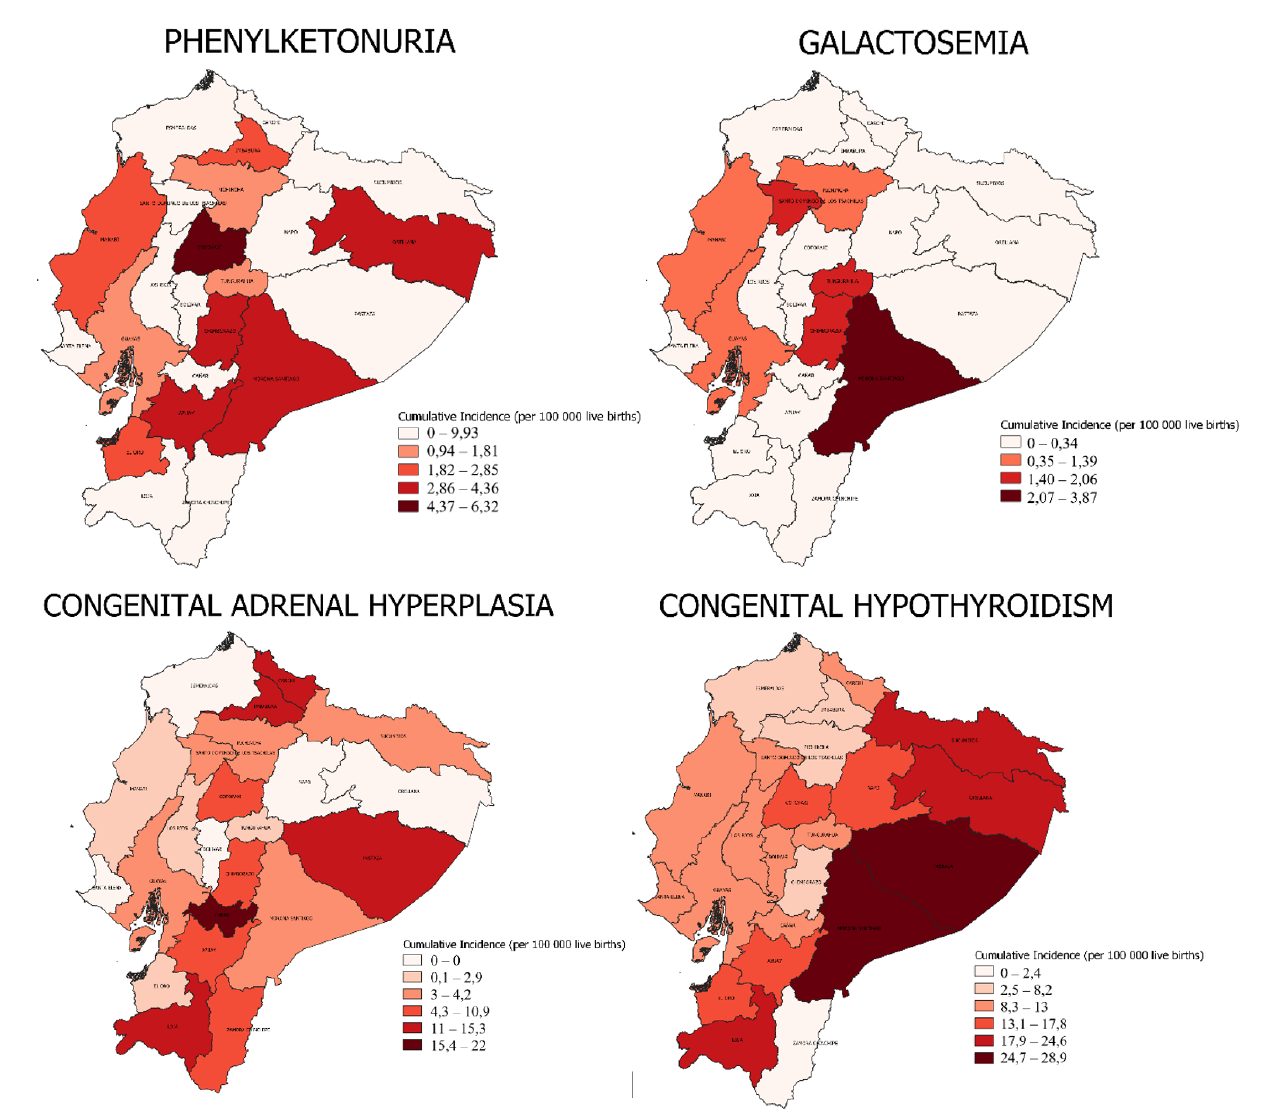
Figure 4. Spatial distribution of newborn screening disorders diagnosed in Ecuador by type disorder, 2012 –